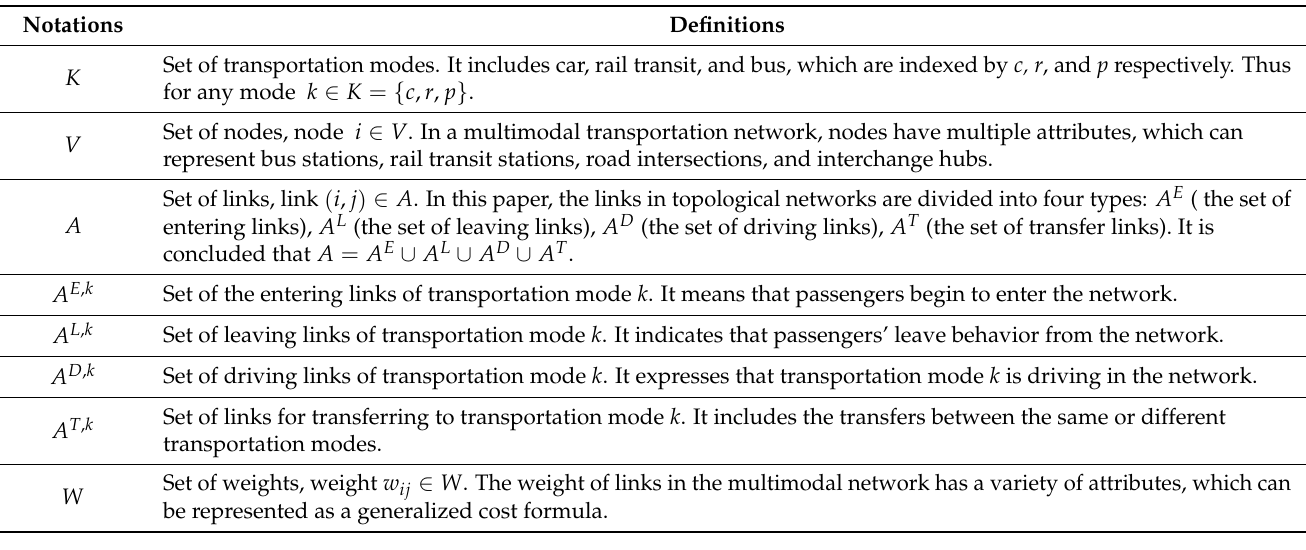
Table 1. The notations and definitions of the multimodal transportation